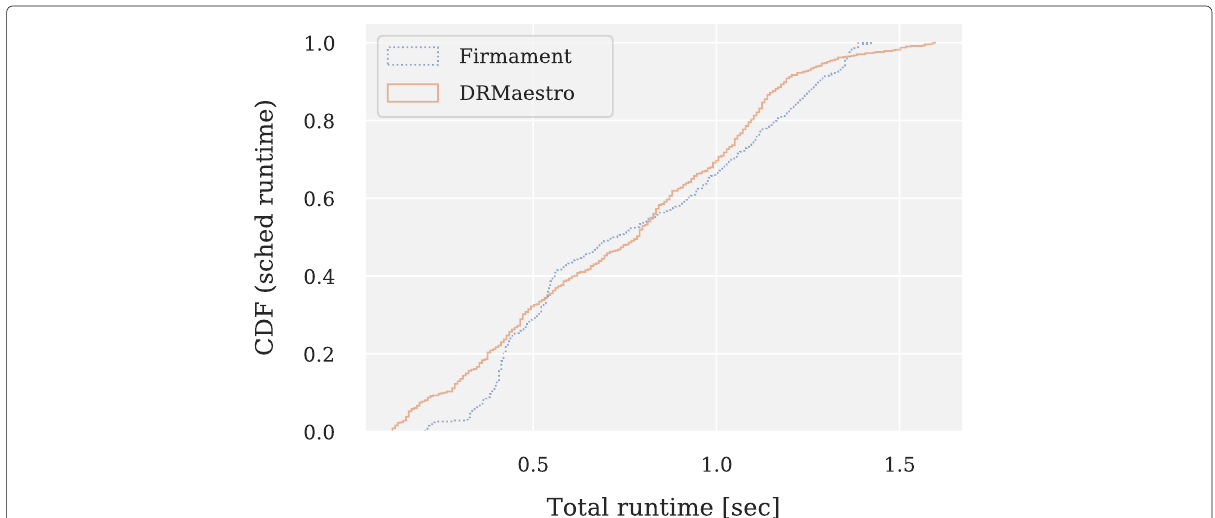
Fig. 8 Scheduler execution time. Both DRMaestro and Firmament scheduler appear to have similar overhead, expect that DRMaestro runs slower in some cases for the scenario with 4096 jobs and 128